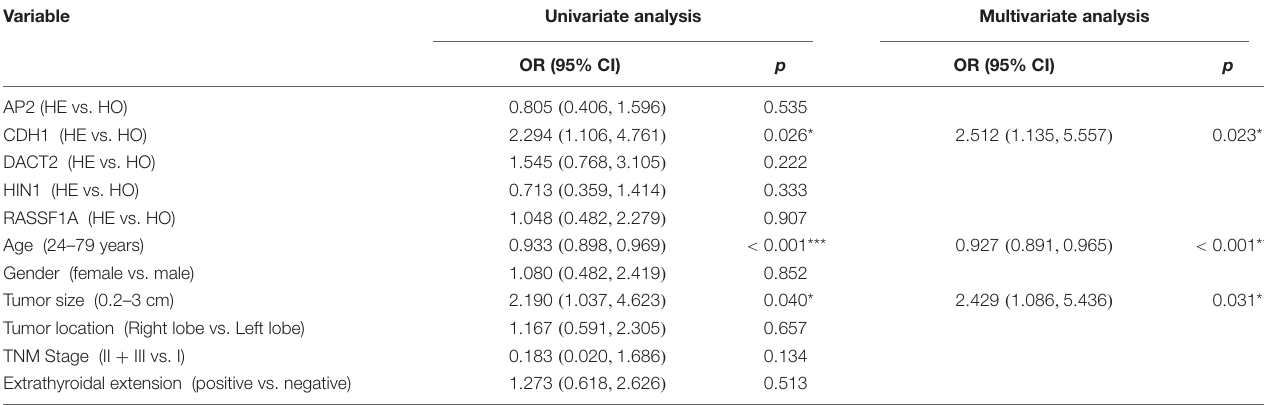
TABLE 4 | Logistic regression model for lymph node metastasis. Variable